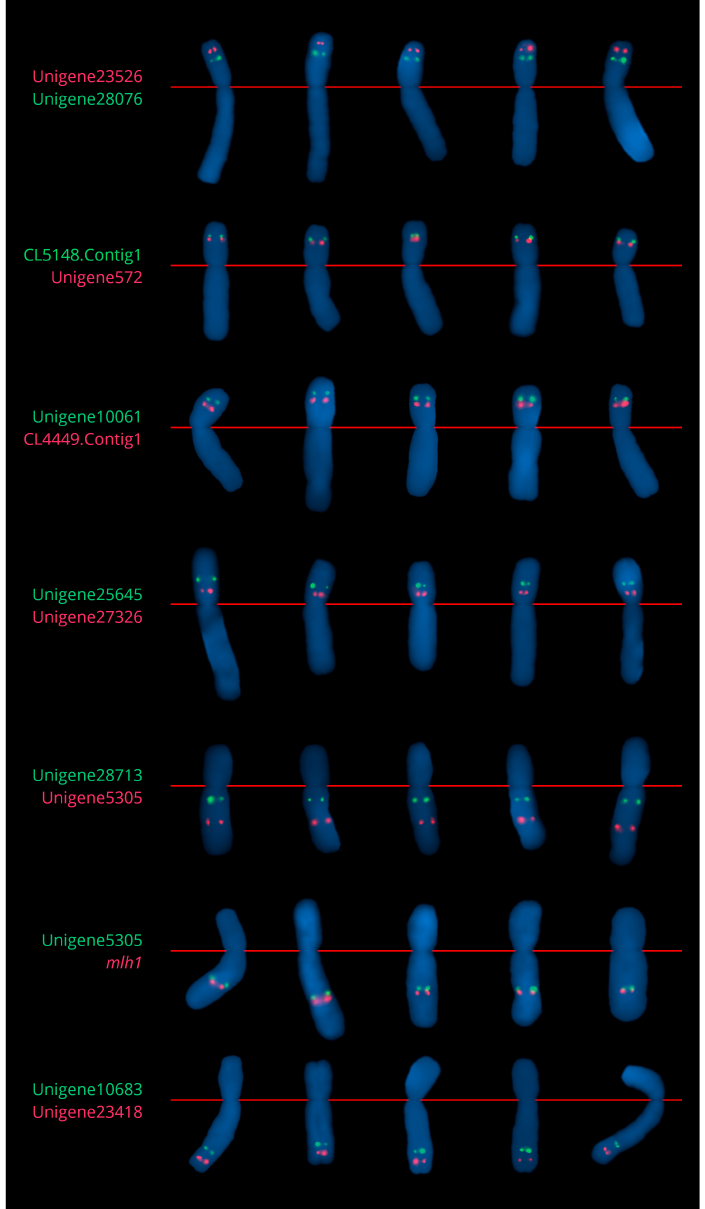
Figure 2. Dual-color Tyr-FISH using selected markers/gene from transcriptome map of chromo- some 2. Extracted chromosome 2 from mitotic metaphase of Allium cepa